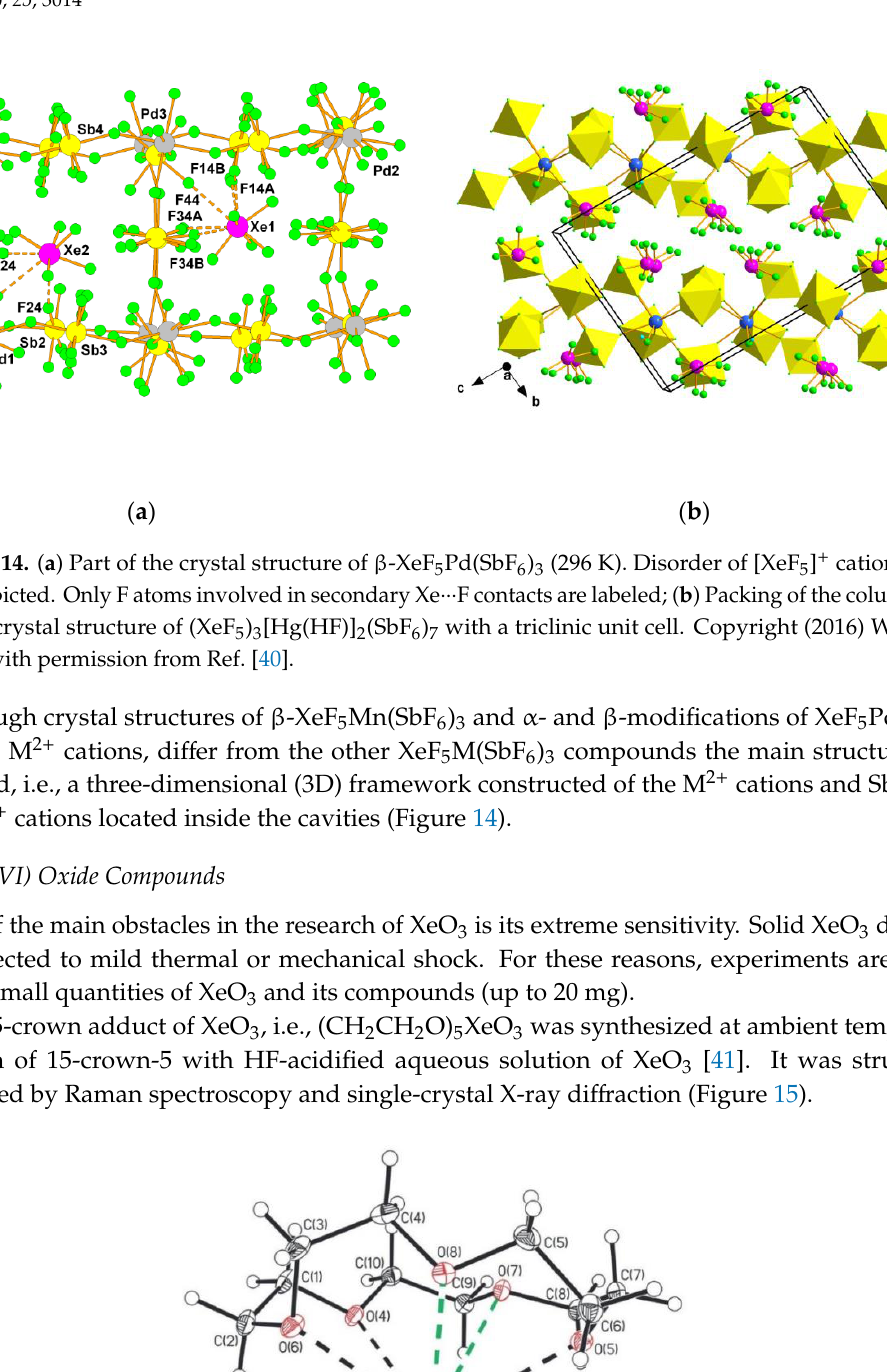
( b ) Figure 13. ( a ) Packing of [NO 2 ] + and [XeF 5 ] + cations, and [SbF 6 ] − anions in the crystal structure of NO 2 XeF 5 (SbF 6 ) 2 ; Only one of the two orientations of the disordered [SbF 6 ] - anions is depicted. Copyright (2015) Wiley. Used with permission from Ref. [39]; ( b ) The tri-dimensional [M(SbF 6 ) 3 ] − framework with the monoclinic unit cell in the crystal structure of  -XeF 5 M(SbF 6 ) 3 (150 K; M = Mn) isotypic to M 2+ = Mg, Co, Ni, Zn, and Cu compounds. The [XeF 5 ] + cations located within the cavities are omitted for clarity. Copyright (2016) Wiley. Used with permission from Ref. [40].